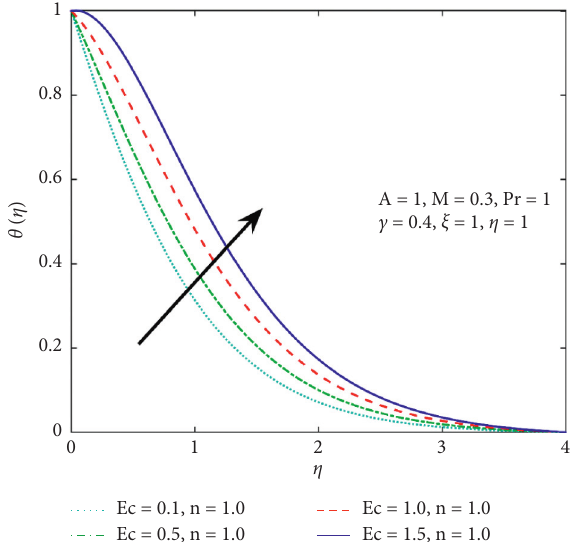
Figure 5: Thermal profile θ ( η ) for different values of Eckert number ( Ec )